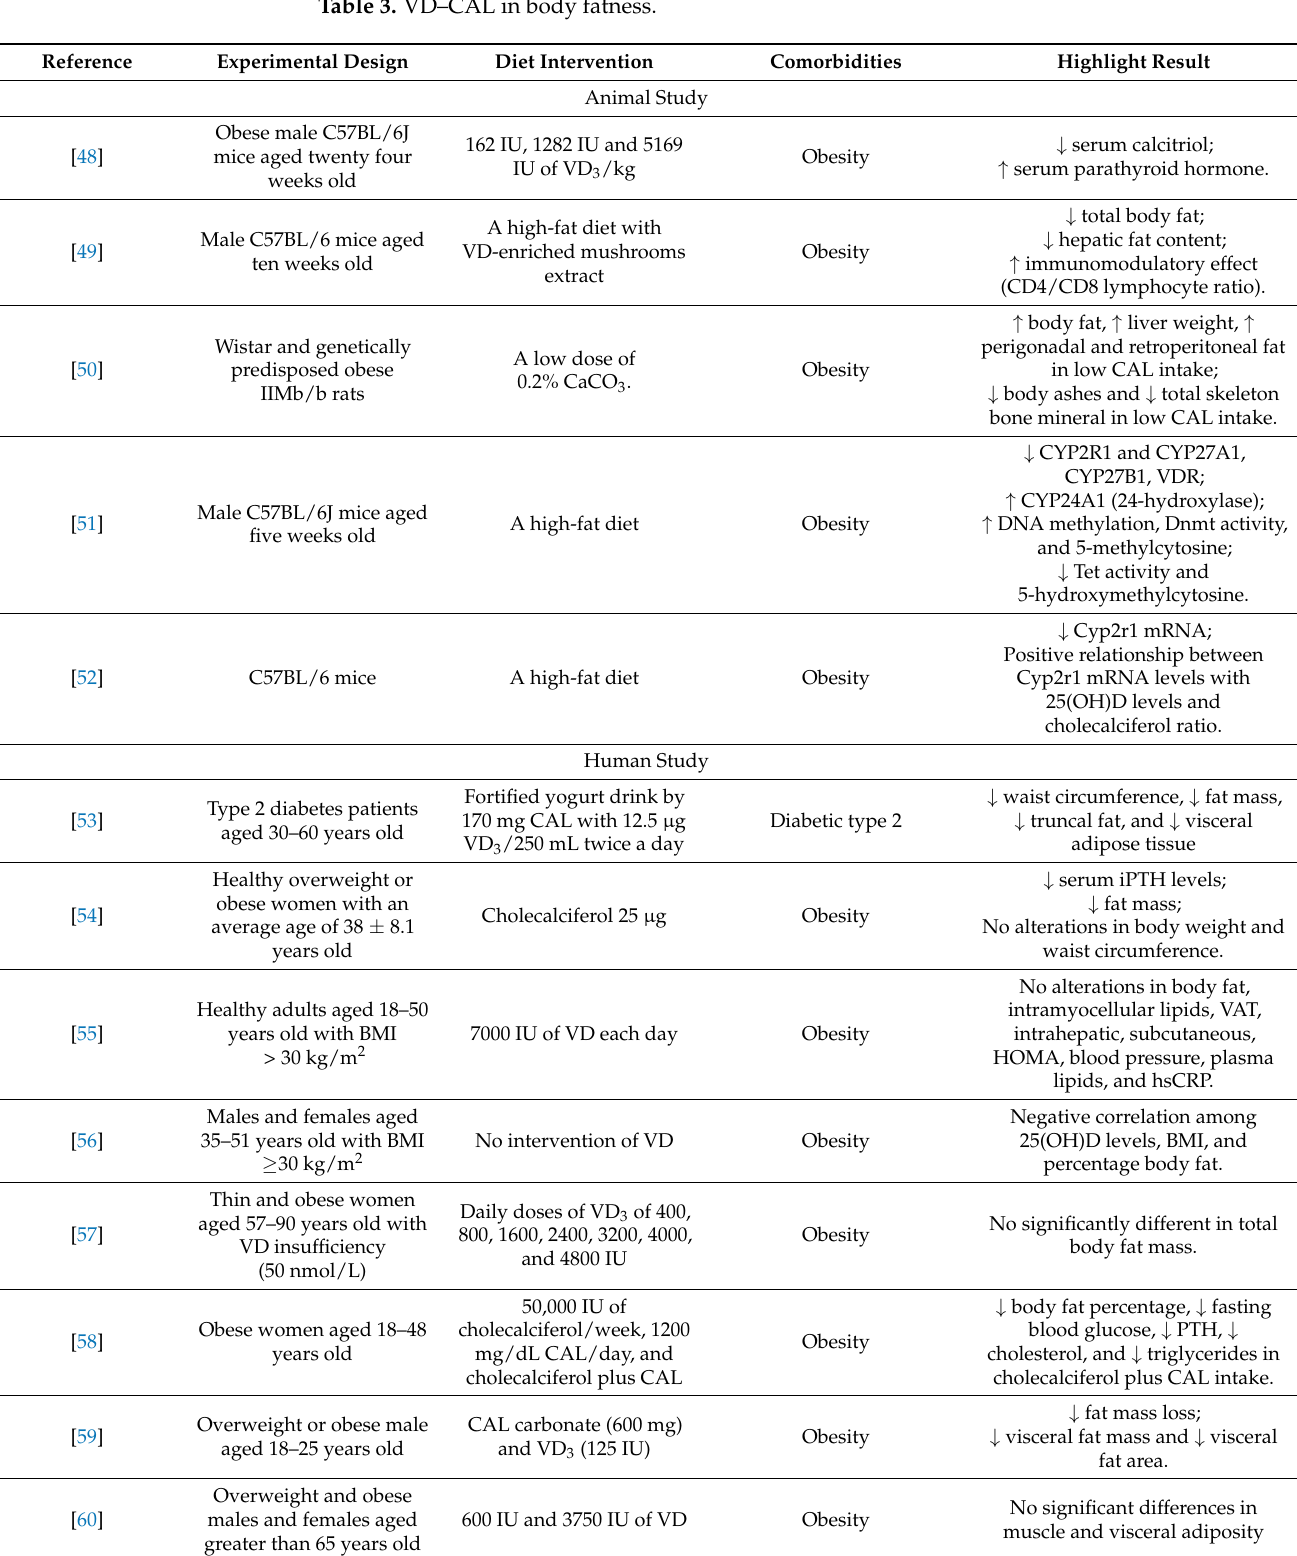
Table 3. VD–CAL in body